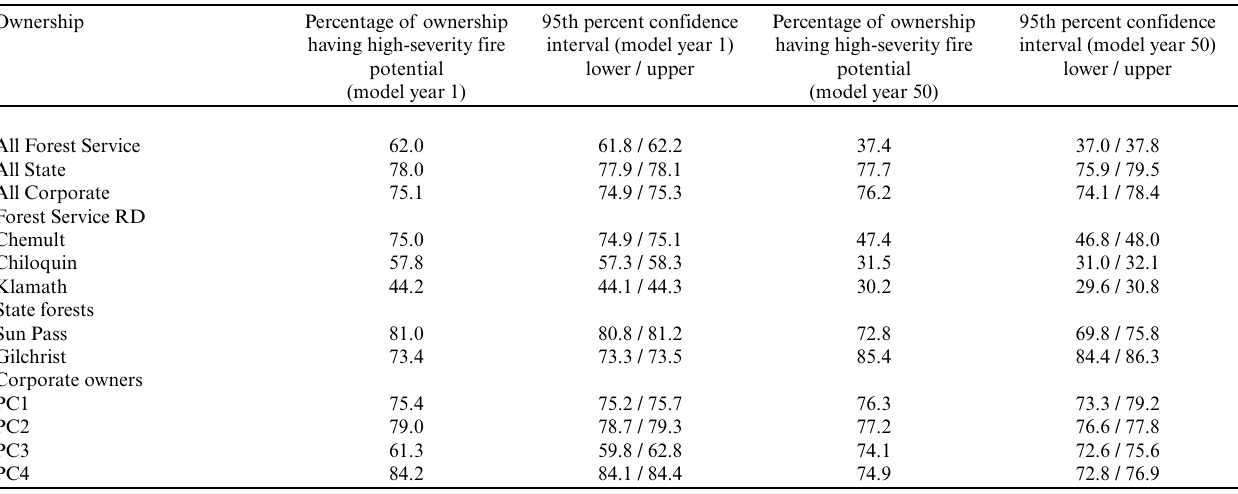
Table 8. Potential fire hazard by ownership, modeling year 1 and year 50 Ownership